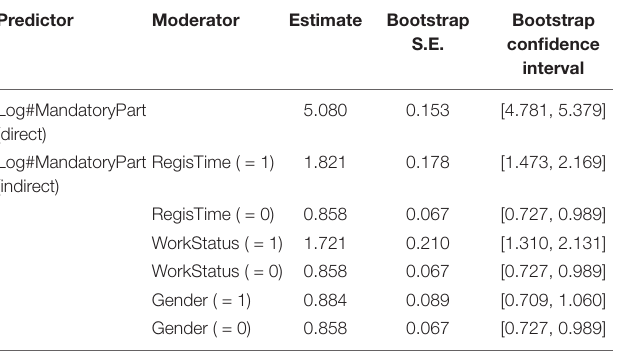
TABLE 7 | Bias corrected indirect effect of mandatory participation on learner performance and the moderation effects ( n = 27,767). Predictor Moderator Estimate Bootstrap